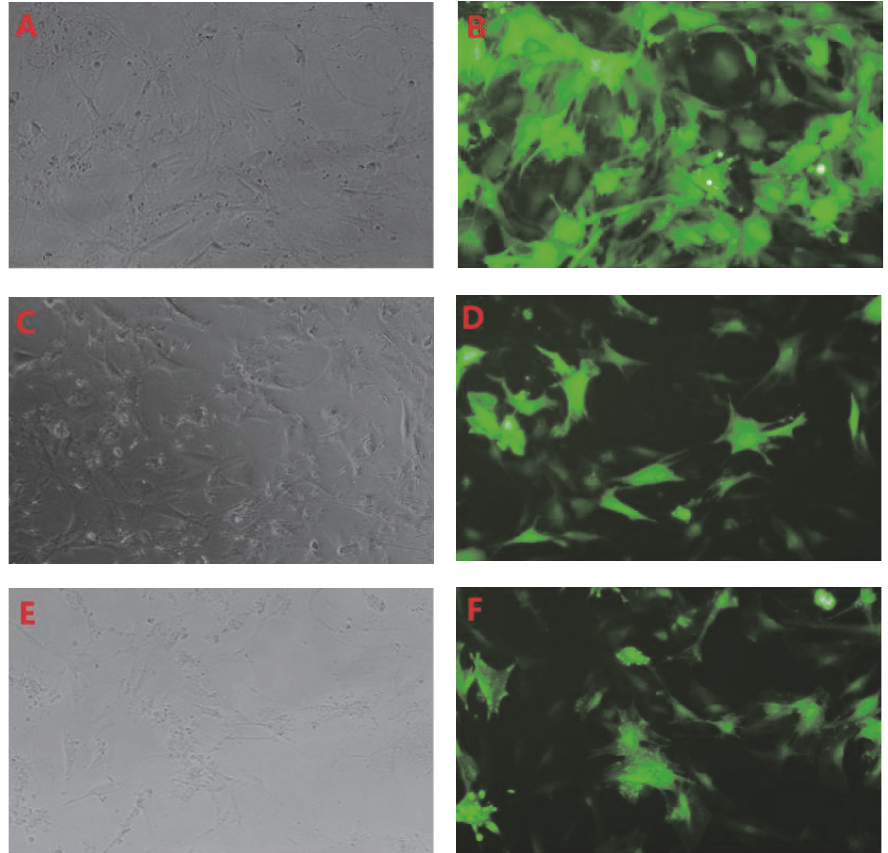
Figure 1: GFP-LC3B tracer technique showed that autophagy was induced in NP cells treated with high glucose condition ((A, C, E) light microscope; (B, D, F) fluorescence microscope. (A) and (B) represent glucose concentration as 5.6 mM; (C) and (D) as 0.1M; (E) and (F) as 0.2 M,